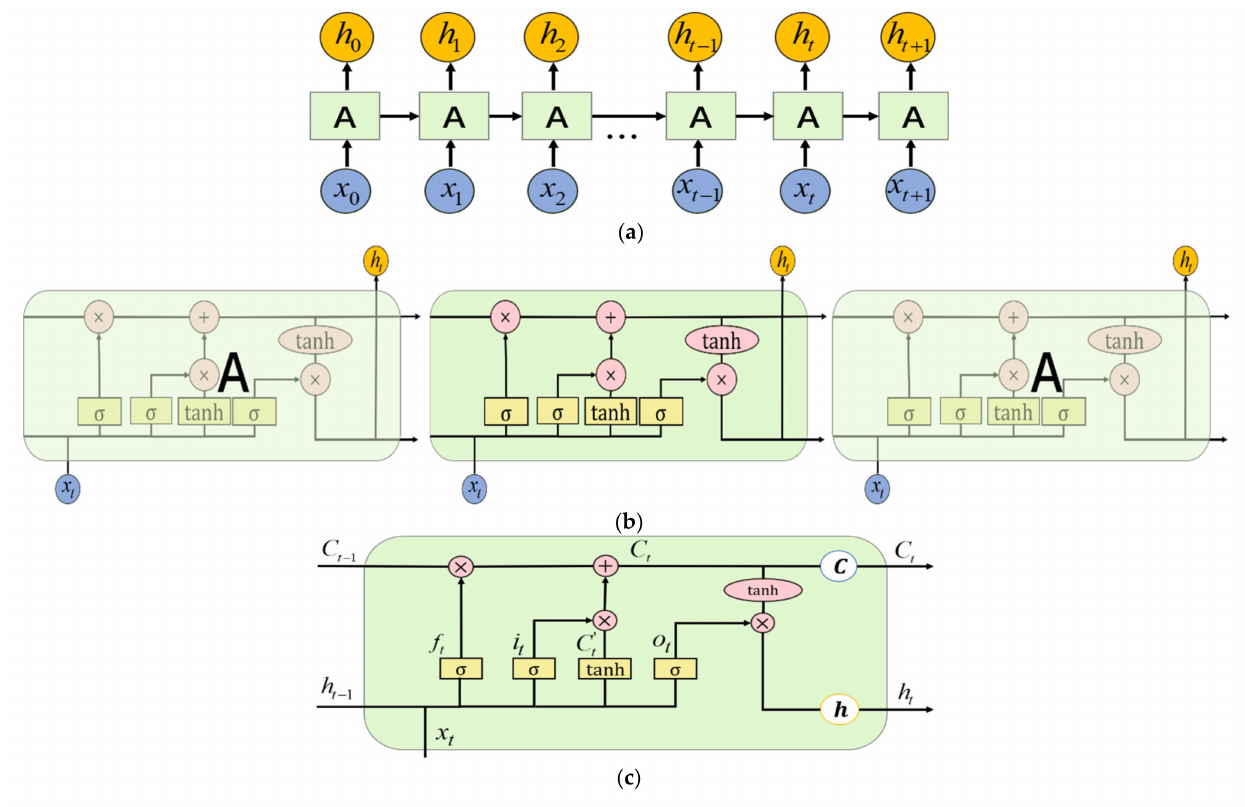
Figure 2. Long Short-Term Memory (LSTM) network structure diagram. ( a ) Recurrent structure of the network [62]. ( b ) LSTM overall network structure [62]. ( c ) LSTM network processing unit A